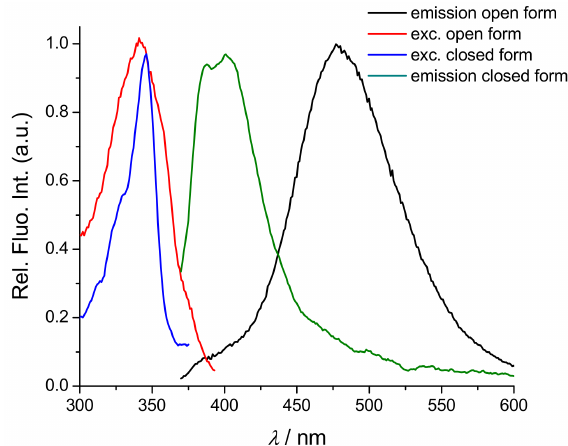
Figure 3. Normalized fluorescence spectra of DAE-NH-Py ( c = 1.0 × 10 − 6 M) at pH 7.0, sodium cacodylate buffer, I = 0.05 M (1% DMSO): open DAE-NH-Py: Emission ( – , λ exc = 348 nm) and excitation ( – , λ em = 478 nm) and closed DAE-NH-Py: Emission (spectrum multiplied by 20; – , λ exc = 348 nm) and excitation ( – , λ em = 400 nm)